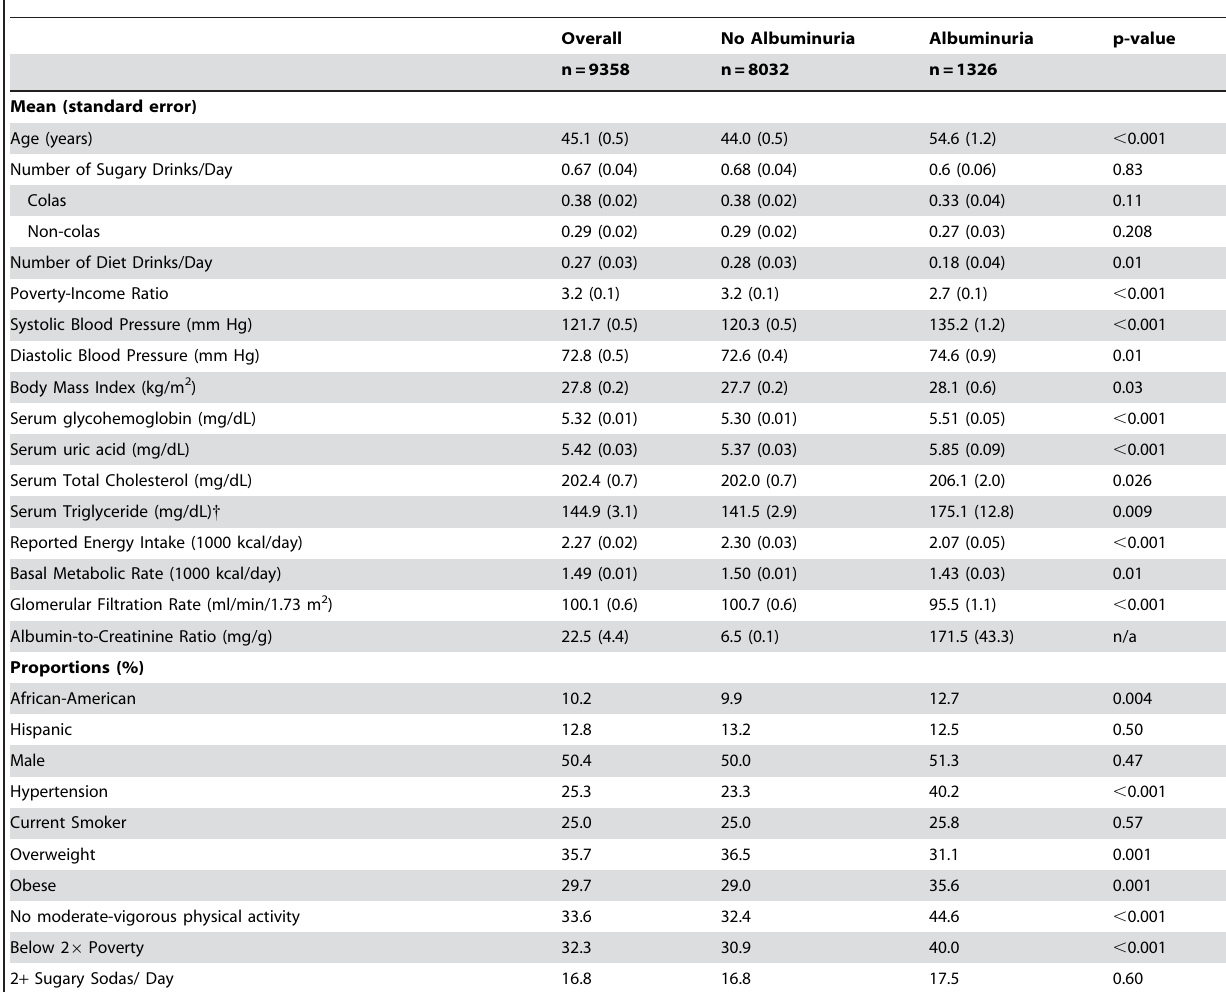
Table 2. Distribution of attributes, National Health and Nutrition Examination Survey 1999–2004, overall and by albuminuria